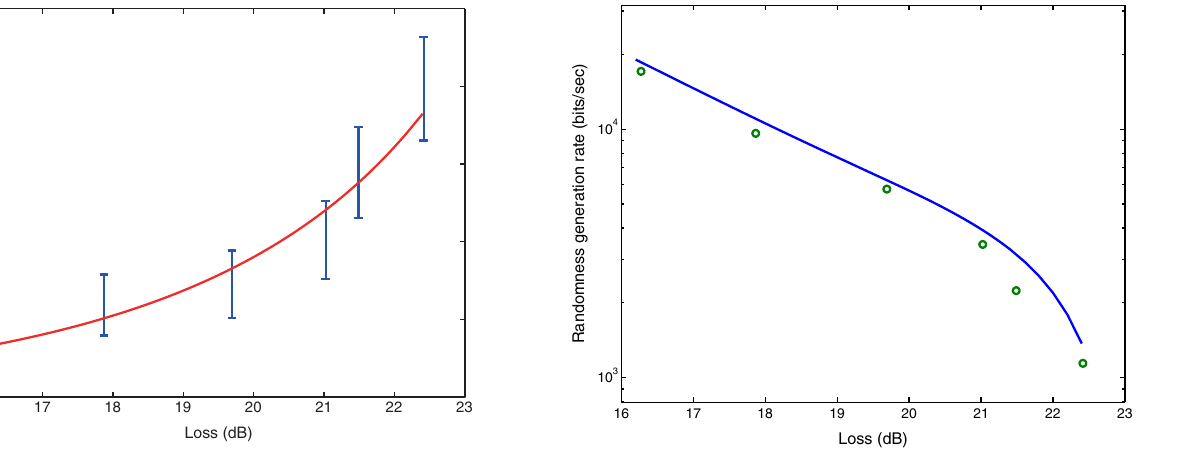
FIG. 7. Dependency of randomness generation rate on the loss. The data points on the figure are taken to be the lower bound of the rate, evaluated by random sampling. The security parameter is ε